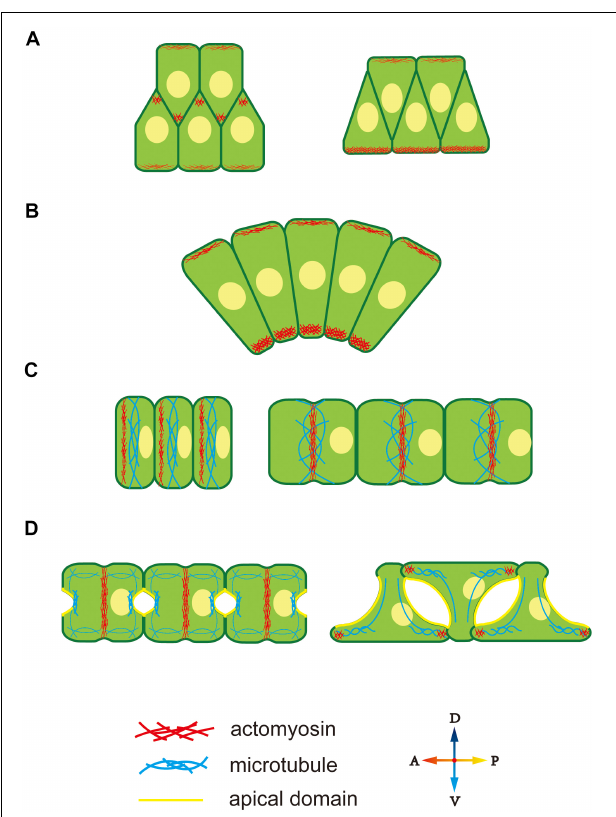
FIGURE 2 | Cytoskeleton polarity during notochord development in Ciona . (A) F-actin accumulates at the lamellipodium tip, providing migrating forces for cell intercalation. (B) Ventrally accumulated actomyosin contractility provides unbalanced force to drive notochord bending. (C) An actomyosin contractile ring forms at the anterior edge and moves to the equator of notochord cells. Actomyosin ring contraction elongates notochord cells. Microtubules are perpendicular to the AP axis within notochord cells. (D) During lumen expansion, microtubules accumulate at the apical domain, and along with bidirectional migration, they rotate 90 ◦ and form oriented bundles toward the leading edges of tractive lamellipodia-like protrusions. An actomyosin contractile ring also exists during lumen expansion and then disappears. At bidirectional migration, F-actin moves to the tip of lamellipodia-like